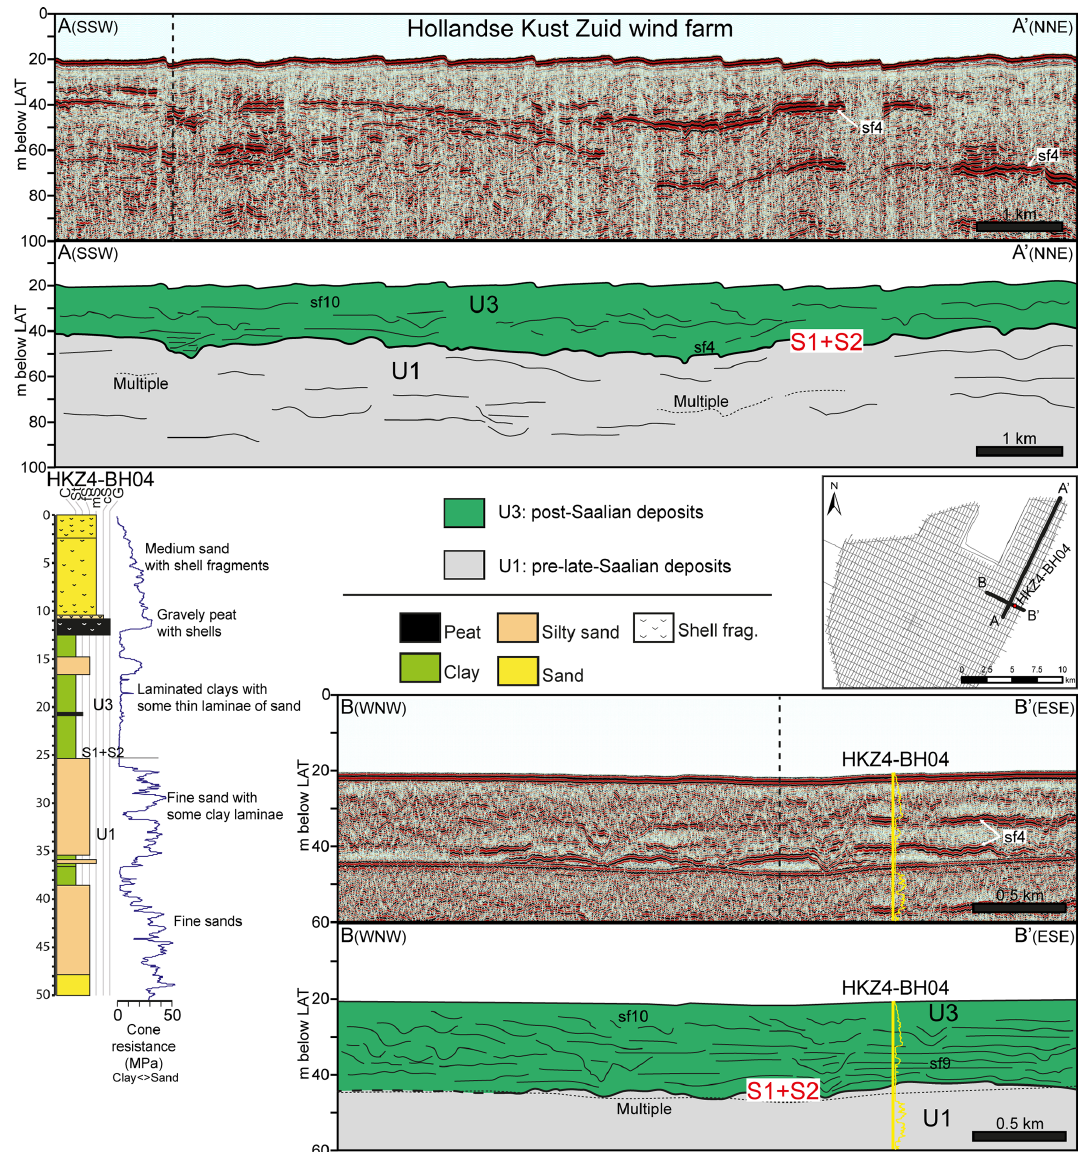
Figure 7. Representative seismic profiles showing the stratigraphy underlying the HKZ wind-farm site. Section A–A (cid:48) corresponds to a multi- channel sparker line and section B–B (cid:48) to a single-channel sparker line. Borehole HKZ4-BH04 illustrates the sedimentological characteristics of units U1 and U3 in this wind farm. Only the upper 50m of the borehole is shown. Cone resistance from a CPT obtained at the same site is displayed on the side of the borehole and in the seismic profiles. For the location of the seismic profiles and the borehole see the inset map. Grain sizes – C: clay, St: silt, fS: fine sand, mS: medium sand, cS: coarse sand, G: gravel. The vertical dashed line indicates the position at which the seismic profiles cross each